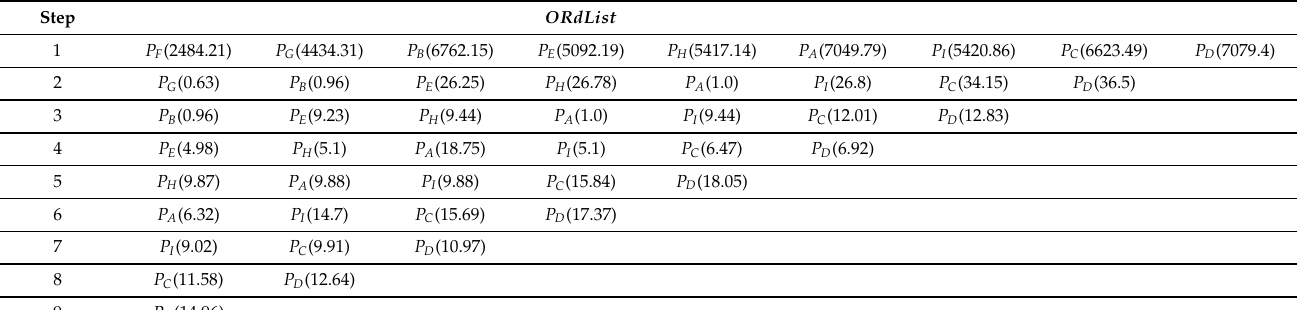
Table 1. Planning Step in Figure 5 ( PositionNo . and div _ r